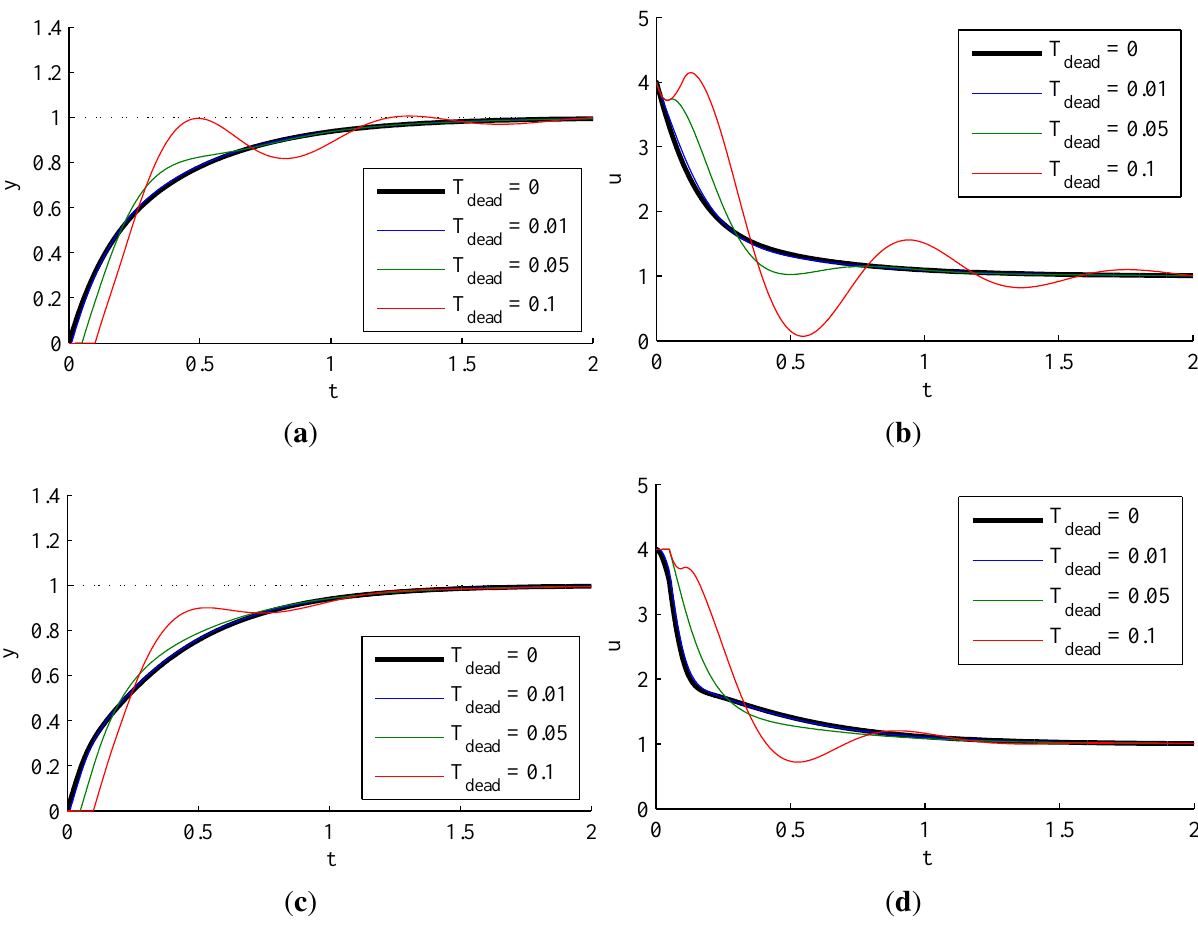
Figure 7. Experiment 3.1.4: effect of dead time, T , on a first-order ADRC controlling dead a process with first-order dynamics ( K = 1, T = 1) and unknown dead time. ADRC = K = 1, T = 1, s ESO = 2 s CL . In ( c ) and ( d ), a fixed dead time, T ESO parameters: b 0 settle T ·